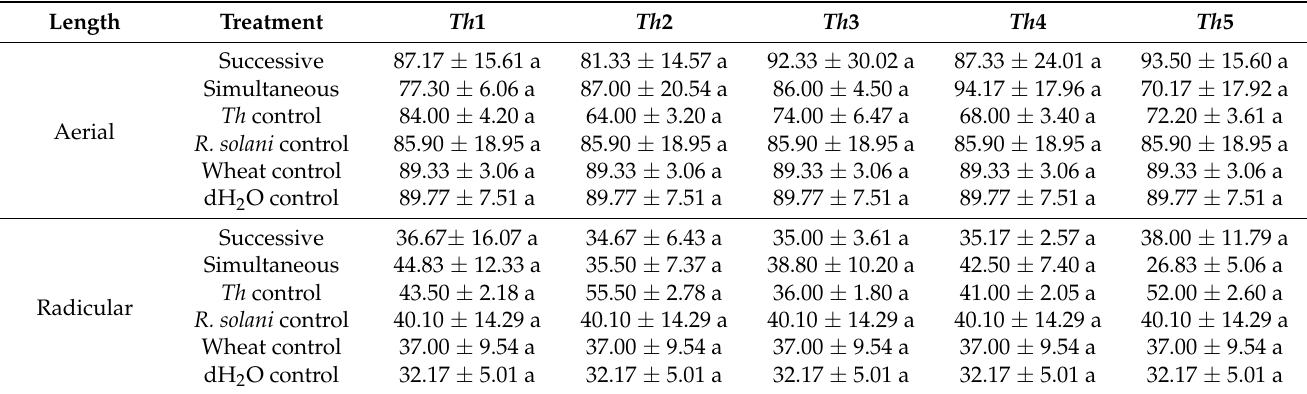
Table 6. Total aerial and root biomass length of grafted plants in cm (mean ± standard deviation) for each type of treatment (successive or simultaneous inoculation with R. solani and T. harzianum , and controls with plants inoculated only with wheat and dipped in distilled water) as a function of the T. harzianum isolate used.